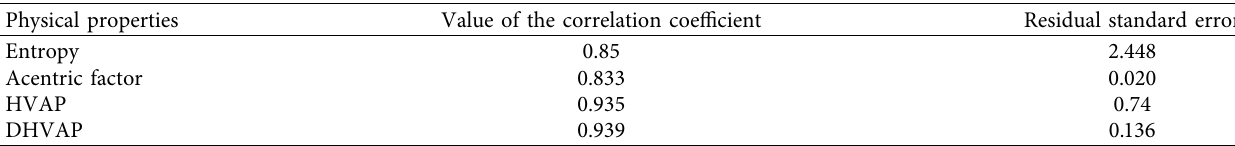
Table 3: Parameters of regression models for the HG index.